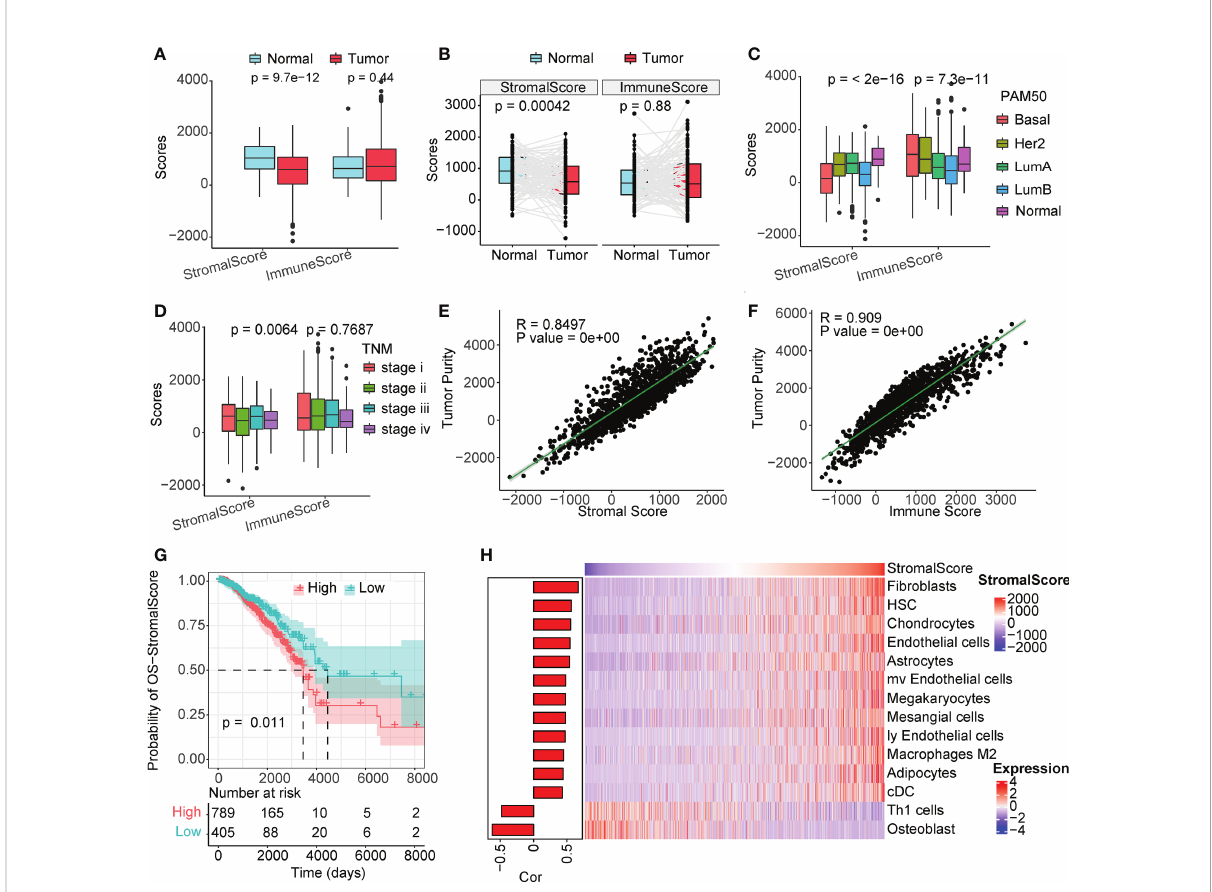
FIGURE 1 Stromal scores are associated with clinical features and outcomes. (A) Analysis of unpaired differences in the distribution of immune and stromal scores in tumors and normal tissues adjacent to the tumor. (B) Analysis of pairwise differences in immune and stromal score distribution in tumors and normal tissues adjacent to the tumor. (C) Analysis of the differences in the distribution of immune and stromal scores among different PAM50 subtypes. (D) Analysis of the differences in the distribution of immune and stromal scores among different TNM stages. (E, F) Association between immune/stromal scores and tumor purity inferred using the ESTIMATE algorithm. (G) Survival analysis of the low and high stromal scores. (H) Correlation between TME cell abundance and immune